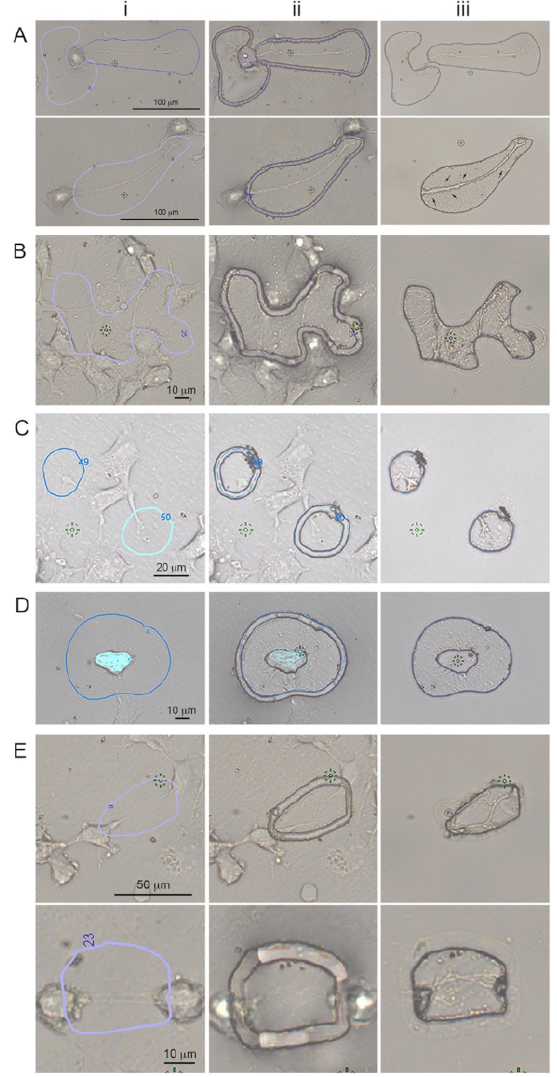
Figure 1. Cellular protrusions isolated by Laser Capture Microdissection. LCM, which uses a finely focused laser to cut a region of interest (ROI), is ideal to isolate cellular protrusions. Cells were